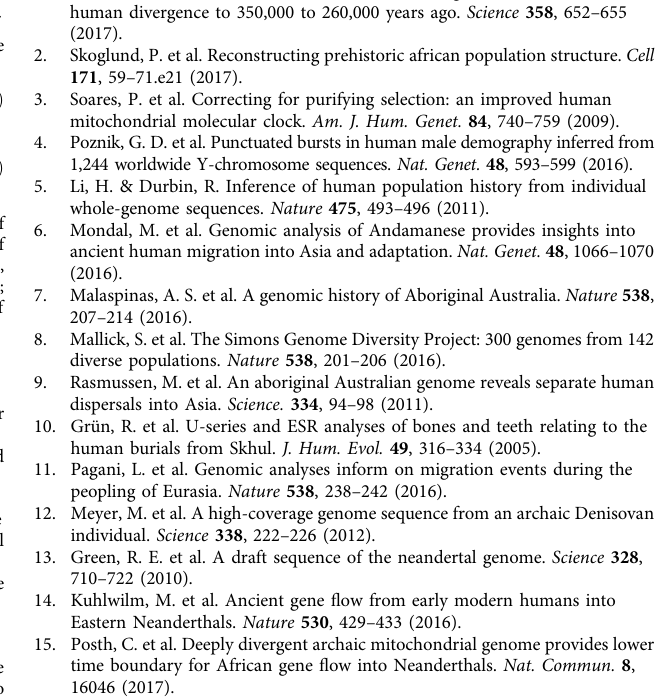
Nucleotide Archive: PRJEB11455 and PRJEB16019) (see Supplementary Table 1). We downloaded four Europeans (EUR), four East Asians (ASN) and four Africans (AFR) BAM fi les from 1000 Genome Project; two Papuans and two Australian Aboriginal (PAC) sequences (FASTQ fi les) from SGDP data set; two Irula,